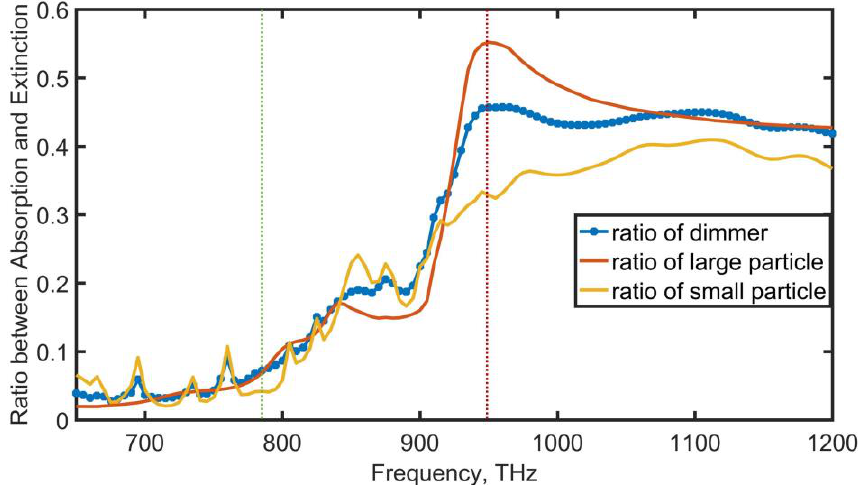
/   ) of two individual MDM nanoparticles and abs ext